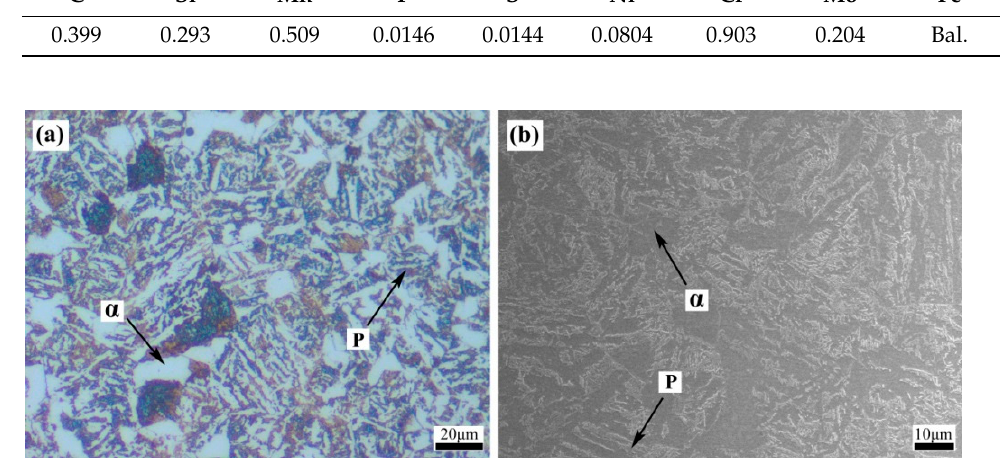
Figure 1. Microstructure of AISI 4135 high-strength steel: OM micrograph ( a ), SEM micrograph ( b ); α —Ferrite, P—Pearlite. Table 1. Chemical composition of the AISI 4135 steel used in this work (wt.%).